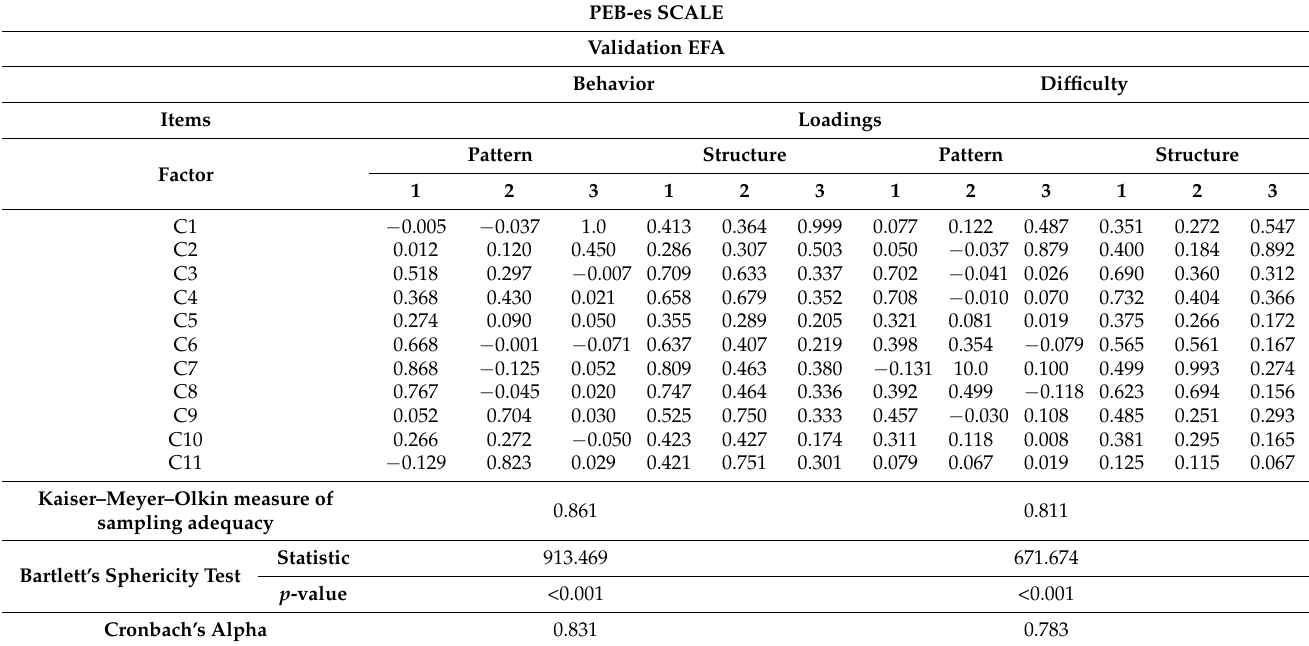
Table 6. Factor loadings and Cronbach’s alphas for the Nurse Professional Ecological